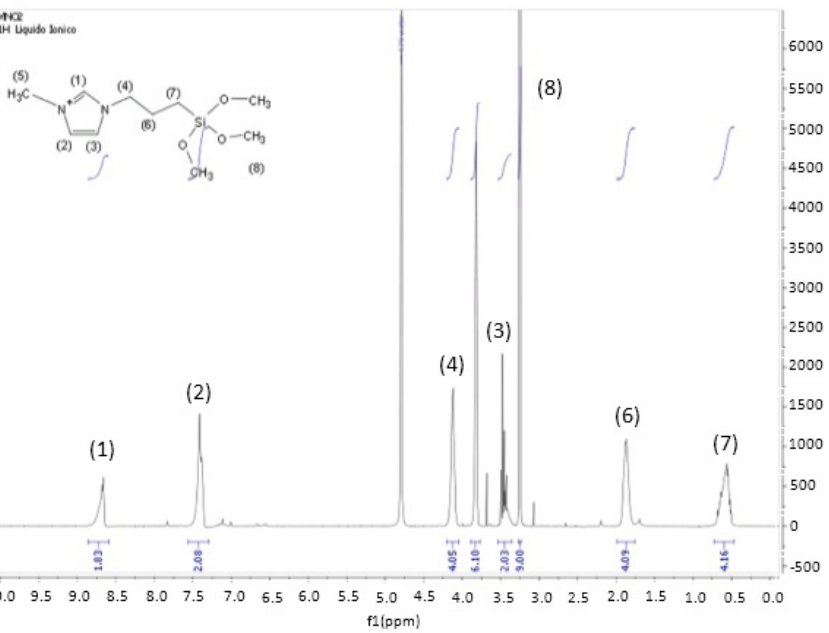
Figure 1. Spectrum NMR of 1-ethyl-3-methoxysilyl propyl